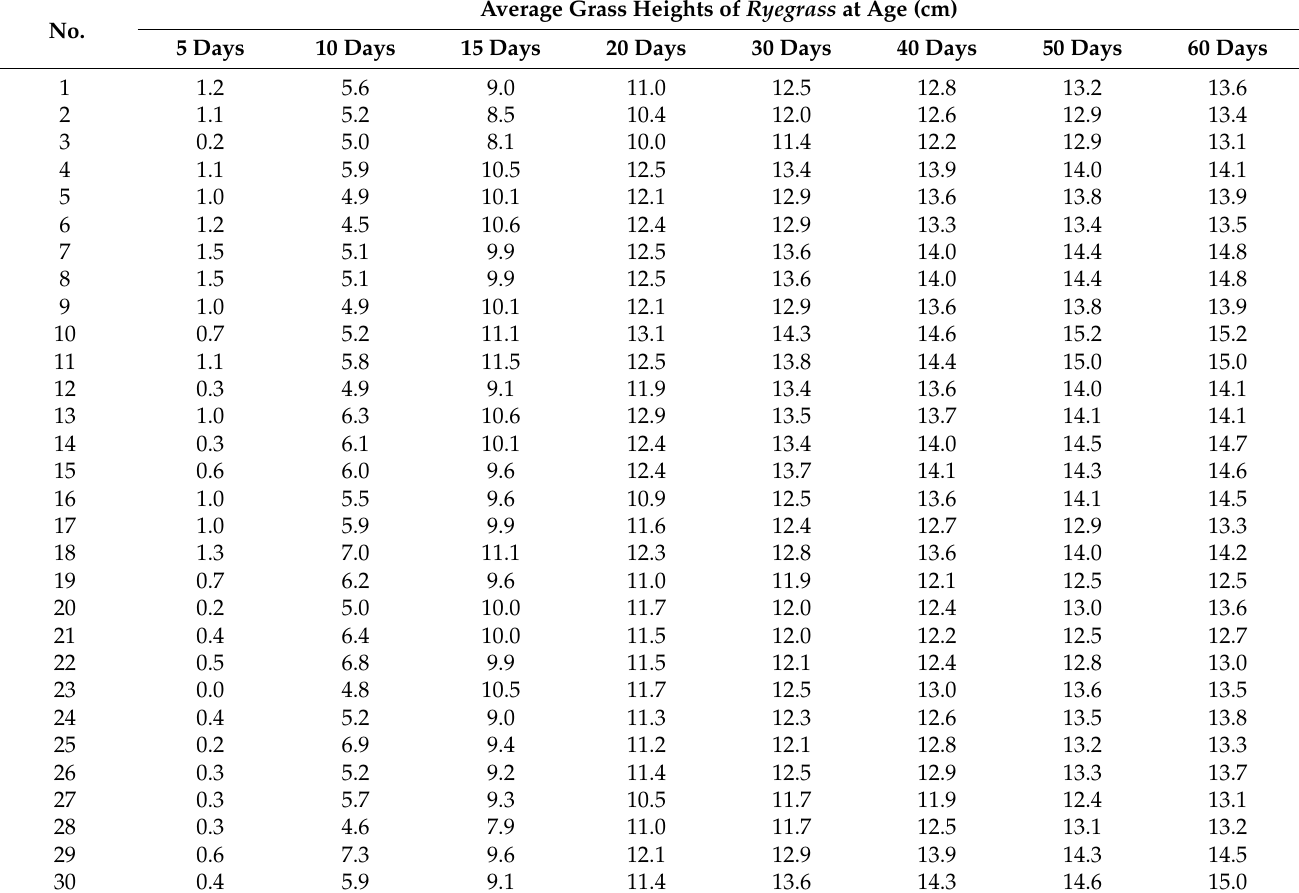
Table 4. Average grass heights of Ryegrass